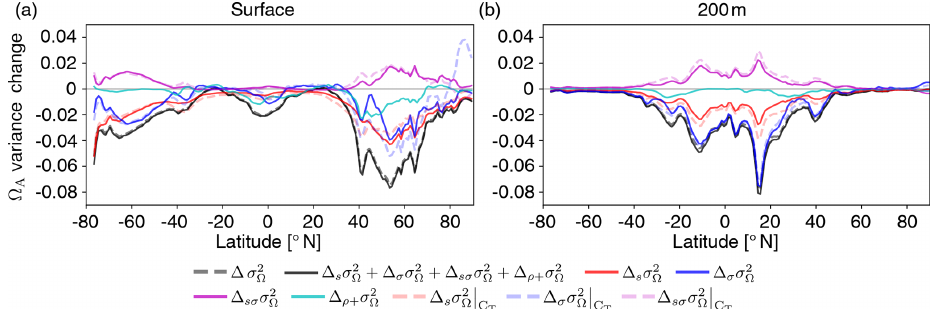
Figure 11. Decomposition of (cid:127) A variability changes into different drivers. The simulated zonal mean contribution to variance changes in (cid:127) A (black dashed lines, (cid:49)σ 2 ) from the preindustrial period to 2081–2100 (RCP8.5) at the surface (a) and at 200m (b) . Shown is the contribution (cid:127) ), standard deviation changes in the drivers (blue lines, (cid:49) σ σ 2 from sensitivity changes (due to mean changes in the drivers) (red lines, (cid:49) s σ 2 (cid:127) simultaneous changes in sensitivities and standard deviations (purple lines, (cid:49) sσ σ 2 ), and all contributions that involve changes in the drivers’ (cid:127) correlations (cyan lines, (cid:49) ρ + σ 2 ). Furthermore, contributions from mean changes, standard deviation changes, and simultaneous mean and (cid:127) standard deviation changes in C T alone are shown (dashed red, blue, and purple lines,